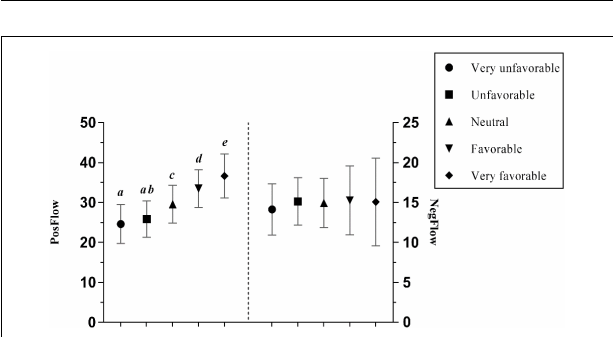
FIGURE 7 | The effects of students’ attitude toward the FL on PosFlow and NegFlow (Means and Significant Differences).